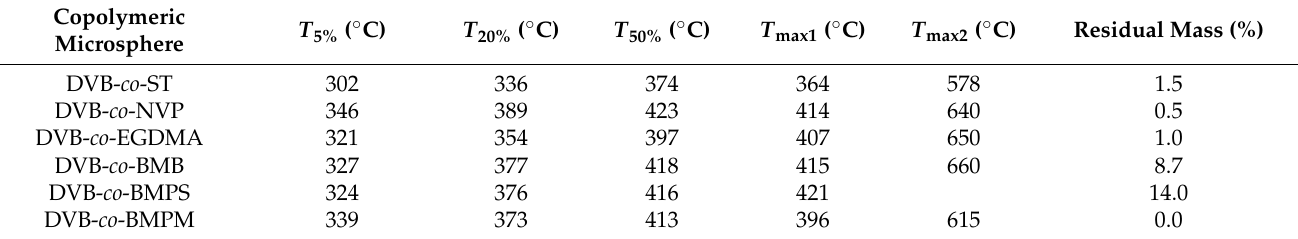
Table 4. TG and DTG data of the copolymeric microspheres obtained in helium